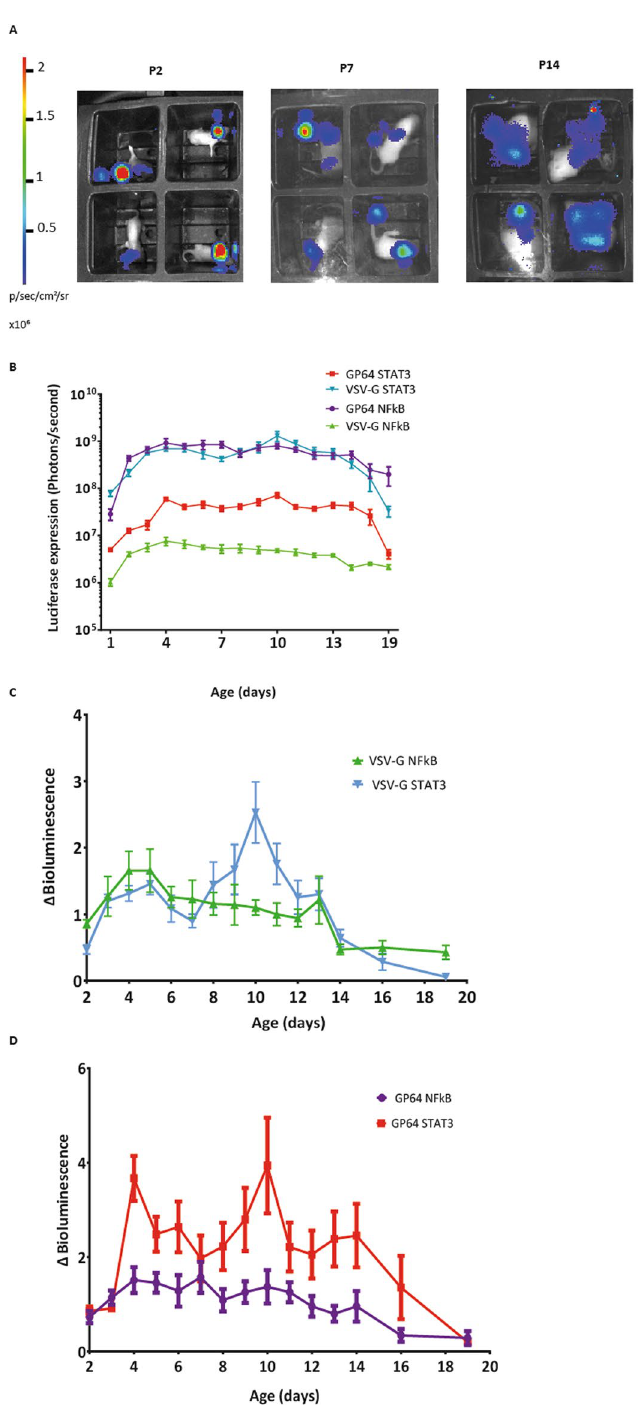
Figure 4. Whole-body conscious bioluminescence imaging of mice after VSV-G or gp64 pseudotyped NF κ B or STAT3 lentiviral vector biosensor. ( A ) Representative images are shown at 2, 7 and 14 days of age. The ROI used were 5 cm by 5 cm and exposure time was 1 minute. ( B ) Conscious whole-body bioluminescence imaging of the mice was undertaken daily until P21 (n = 6) for each biosensor. ( C ) A significant peak in luciferase fold change was observed at P10 of development in mice receiving VSV-G STAT3, (mean + / − SD, P < 0.001). ( D ) A significant peak was also observed in the gp64 STAT3 mice at P10 of development, (mean + / − SD, P <